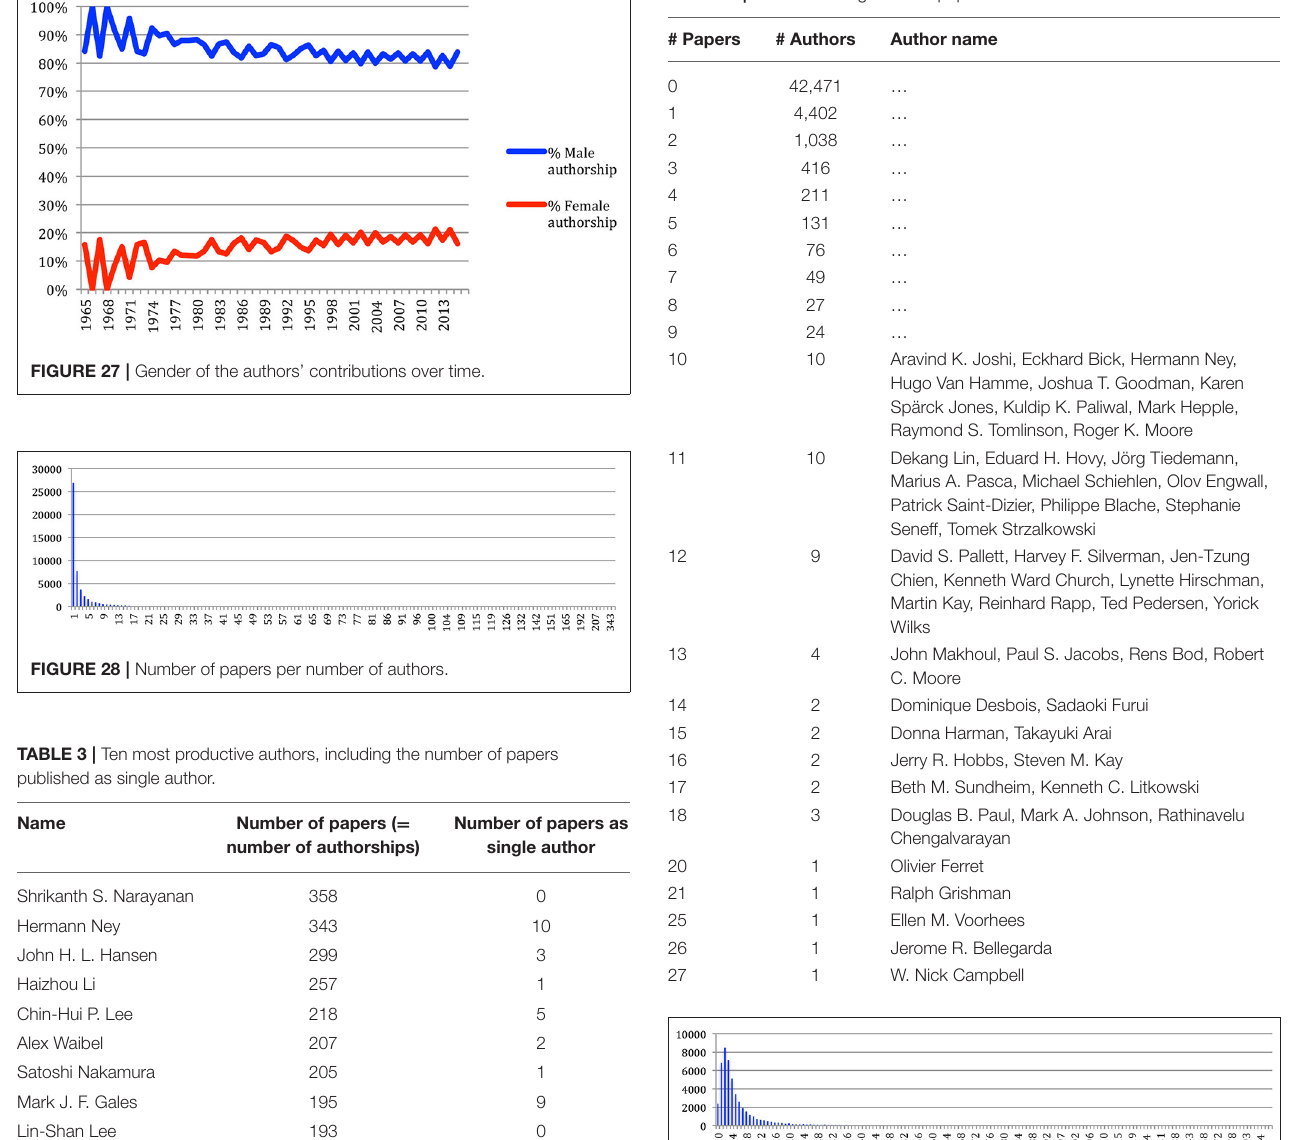
TABLE 4 | Number of single author papers.